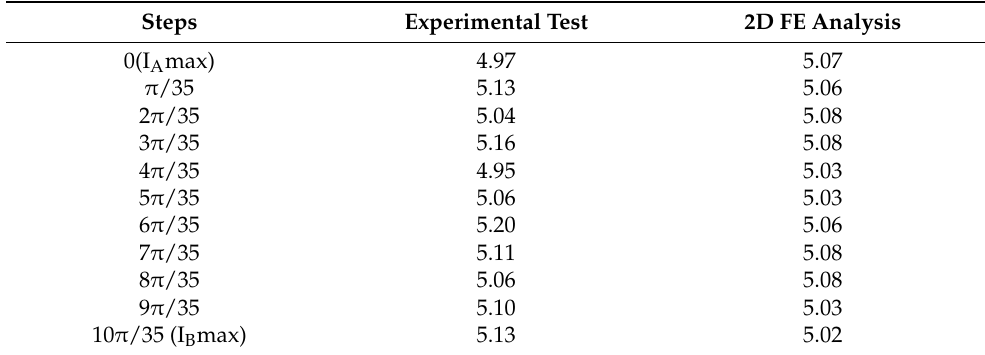
Table 9. Static Torque with different currents.